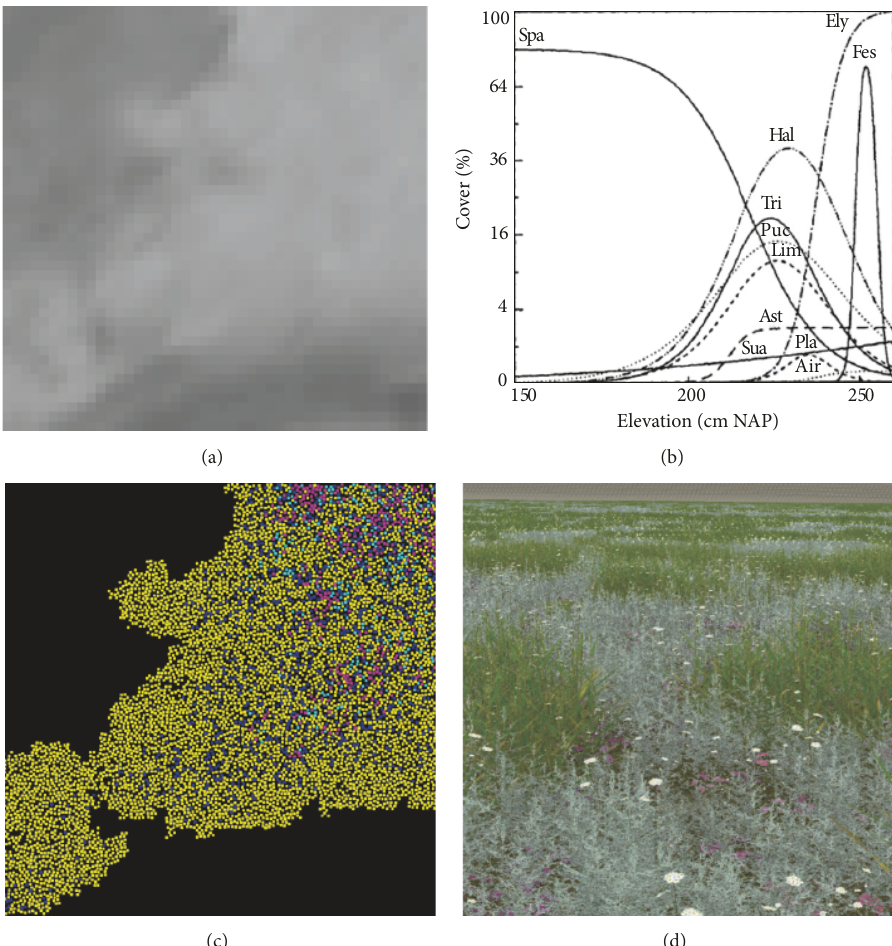
Figure 4: A visual overview of our approach starting with the various input data, such as (a) landscape maps and (b) statistical data [7]. Next, from this data we derive the plant distribution in the vegetation model (c), where each point is associated with plant species. Finally, from this plant distribution we derive the detailed 3D visualization model, suitable for rendering in the browser (d).